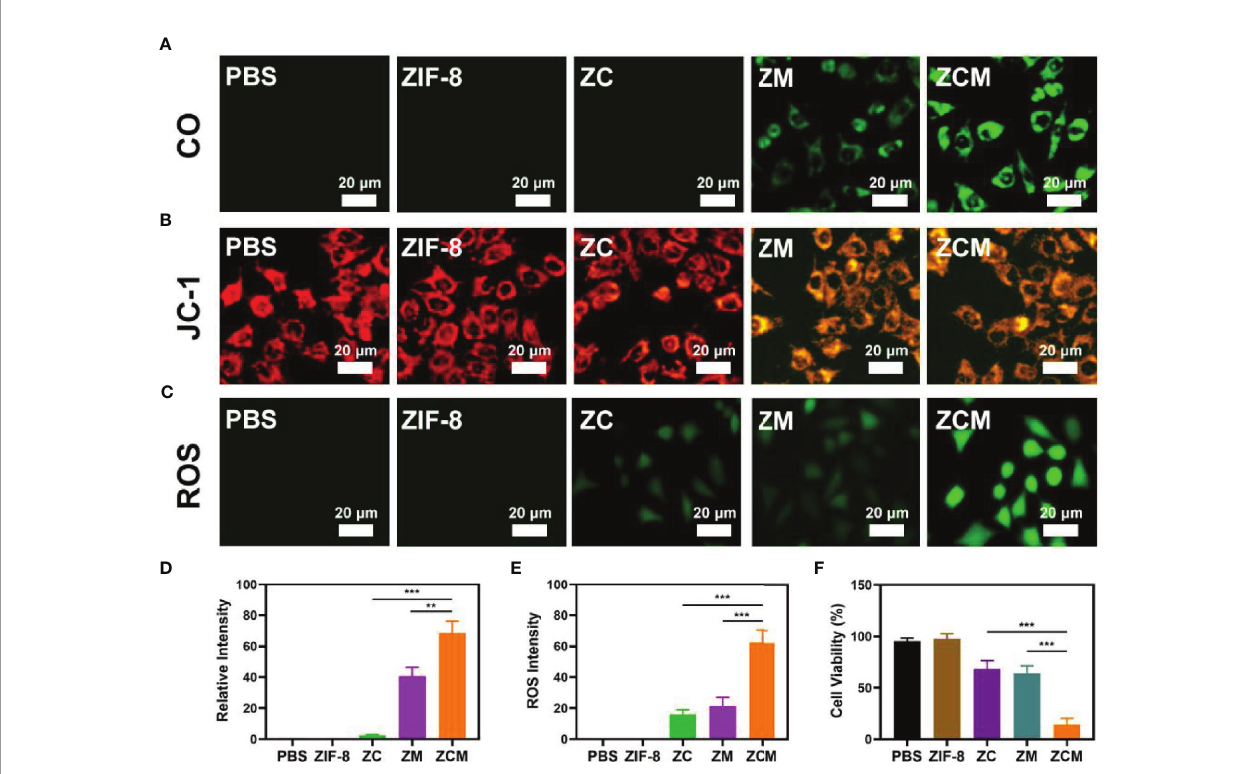
FIGURE 2 | In vitro synergetic therapeutic effects of the ZCM. (A – C) CO (FL-CO-1), JC-1 (green for JC-1 monomer and red for JC-1 aggregate), and ROS (DCFH- DA) fl uorescence images under different treatments. (D) Quanti fi cation analysis of CO (A) based on the relative intensity of counts of at least 100 cells per treatment group (n = 3). (E) Fluorescence intensity of ROS in (C) based on the relative intensity of counts of at least 100 cells per treatment group (n = 3). (F) The survival of CT26 cells with different treatments. **p < 0.01, ***p < 0.005; Student ’ s